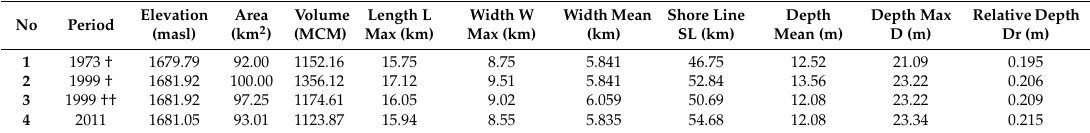
Table 2. Morphometric characteristics of Lake